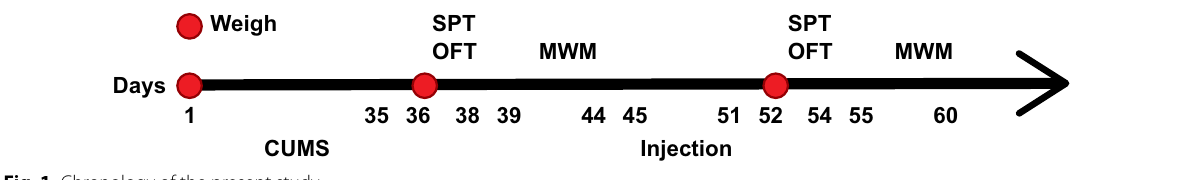
Fig. 1 Chronology of the present